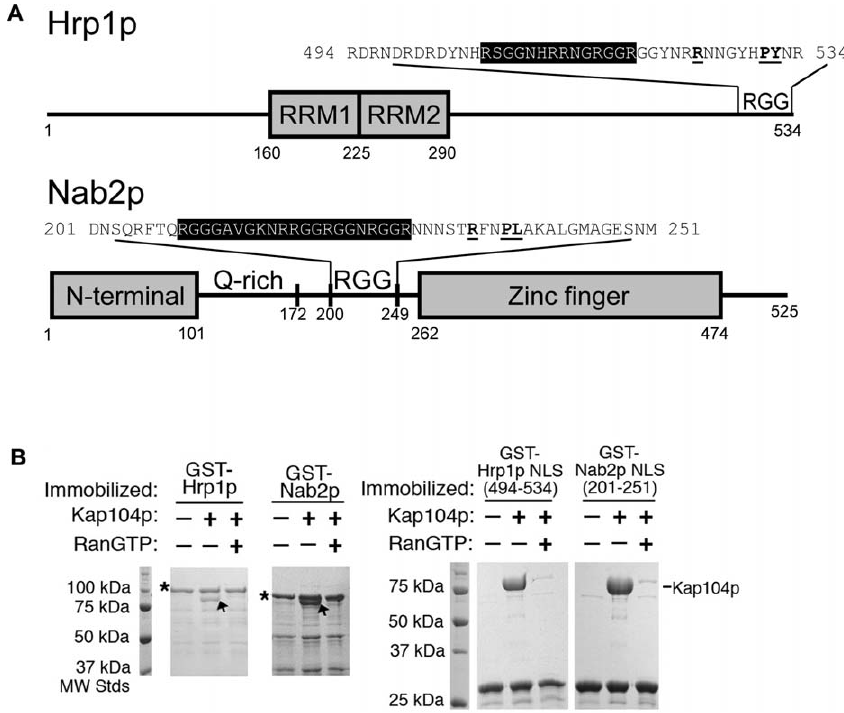
Figure 1. Interactions between Kap104p and Import Substrates Hrp1p and Nab2p (A) Domain organization of Hrp1p and Nab2p. Domains are indicated by gray boxes, and the RGG regions and the glutamine-rich region are labeled. The sequences of the two NLSs are shown, with the basic motif highlighted in black and the RX 2–5 PY(L) motif in bold and underlined. (B) Binding assays of Kap104p (arrow) with immobilized full-length Hrp1p and Nab2p (asterisks) or Hrp1p and Nab2p NLSs, in the presence and the absence of RanGTP. Bound proteins are stained with Coomassie blue.